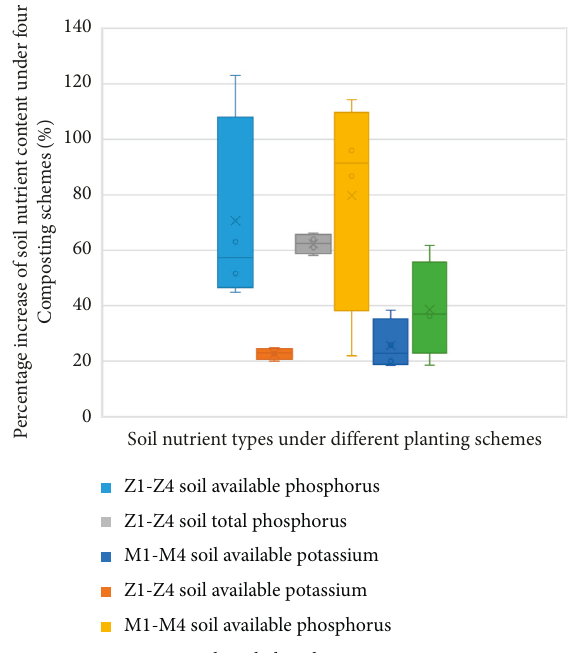
Figure 7: Nutrients changes in the soil with alfalfa and Mexican corn planted after compost